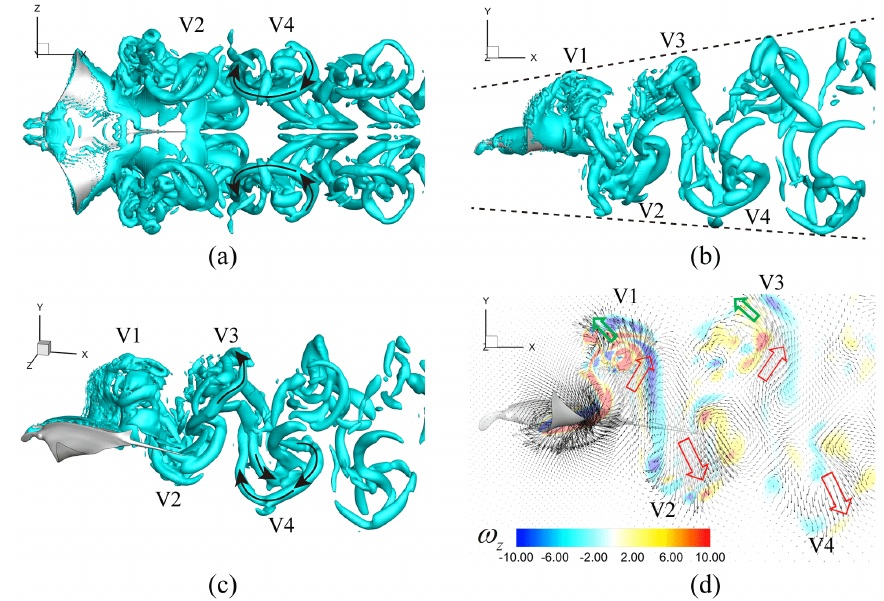
Figure 19. ( a ) Ventral; ( b ) lateral; and ( c ) perspective view of the 3D flow structures at t/T = 0.21; ( d ) vorticity and velocity field on a vertical slice-cut 0.55 half-span away from the middle of the body, which is located in the thrust producing region of the fin. The rotating directions of an upstroke generated vortex ring (V3) and a downstroke generated vortex ring (V4) are labeled by black arrows ( a , c ). Red and green arrows in ( d ) represent backward and forward jets, respectively.